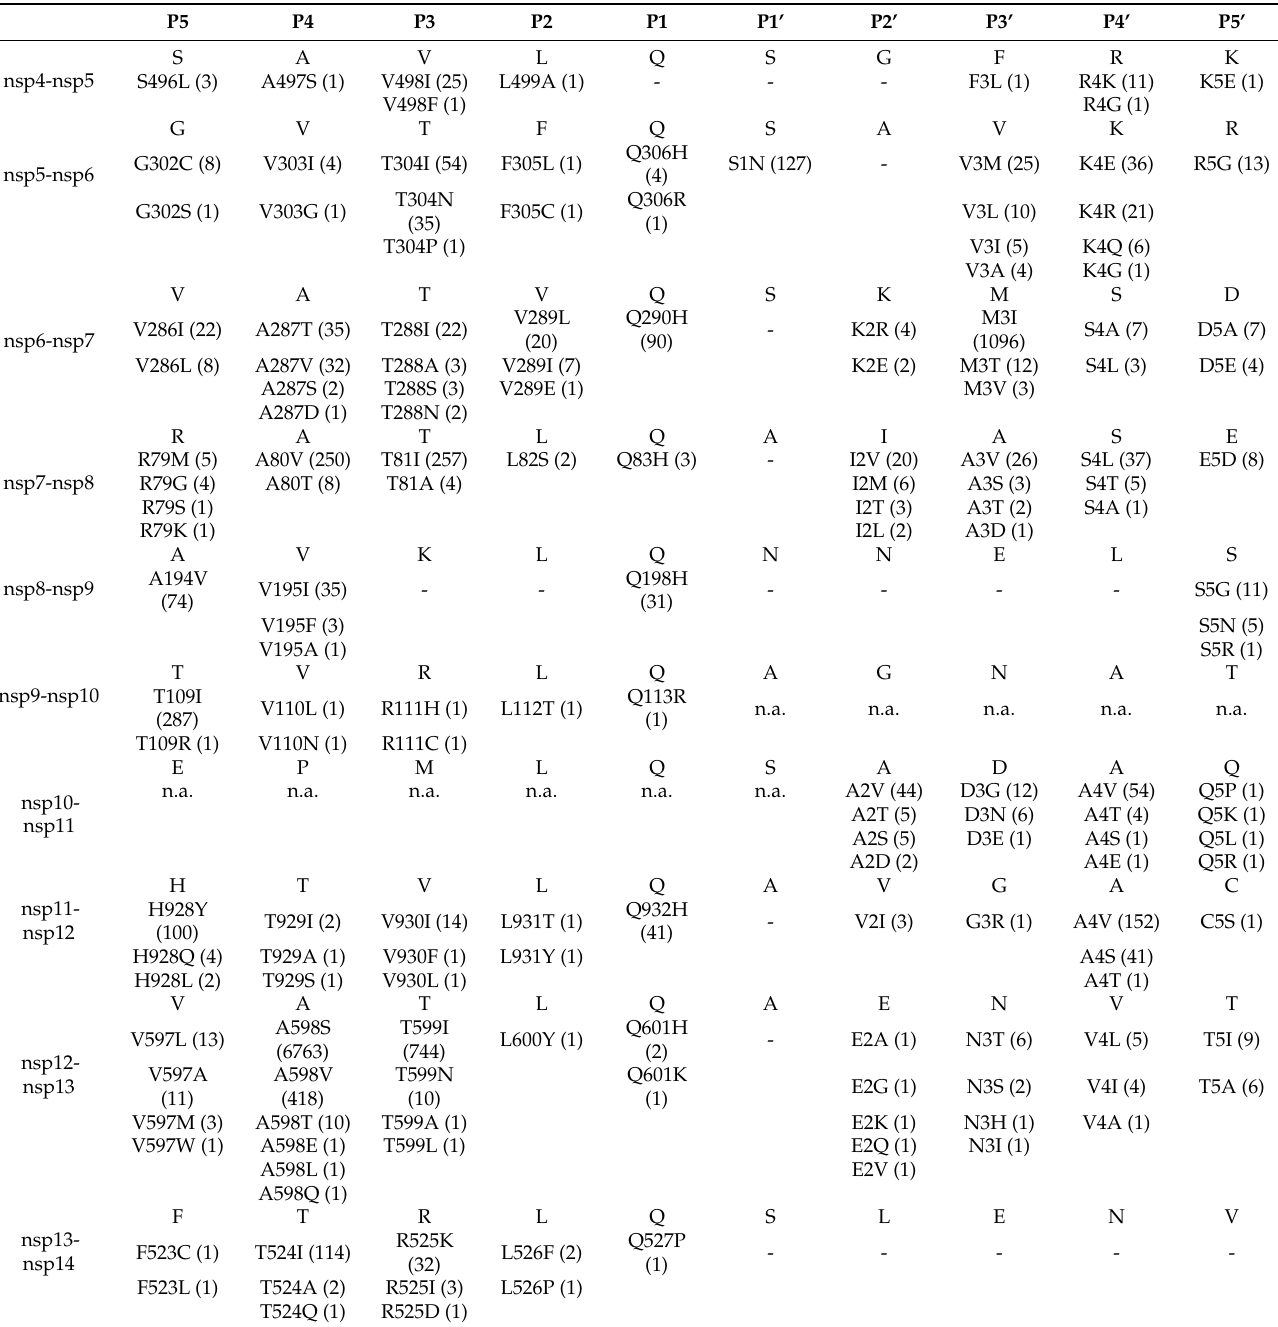
Table 2. Sequence variations of the SARS-CoV-2 Mpro cleavage sites of the polyprotein. The P5-P5’ cleavage site residues are shown, the circulating variants are indicated, and the variant counts are shown in parentheses based on COVID-3D resource. n.a., data are not available; -, no variant at this position is included in the